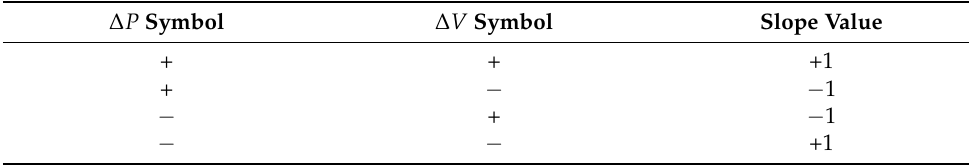
Table 1. Slope value table.